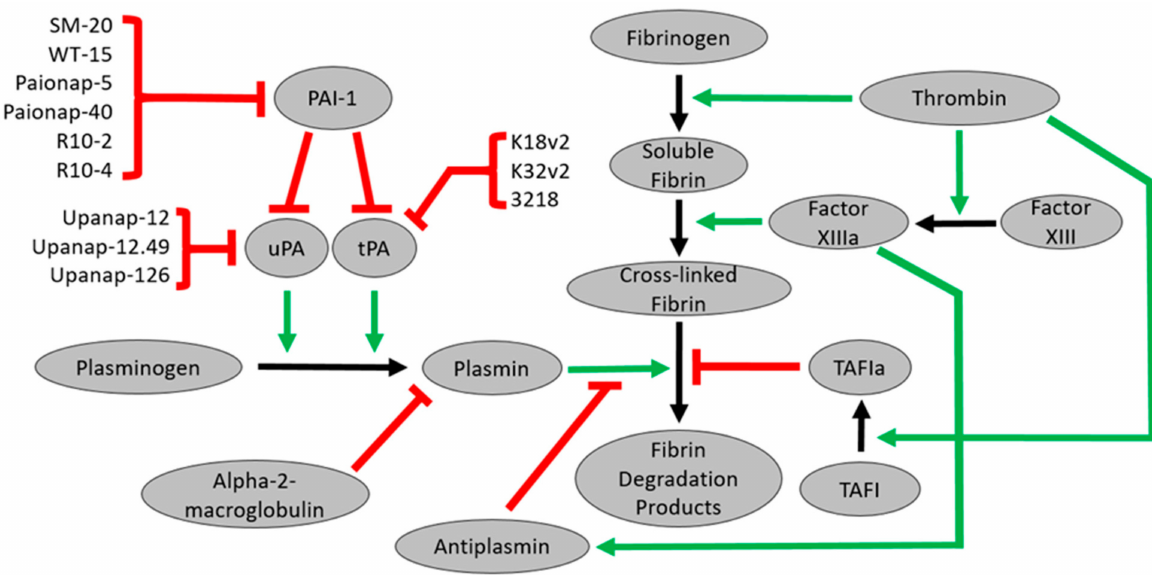
Figure 4. Fibrinolysis pathway aptamers. Paionap-5, paionap-40, SM-20, and WT-15 bind PAI-1, but these aptamers do not alter the PAI-1 antiproteolytic activity. R10-2 and R10-4 inhibit the PAI-1 antiproteolytic against tPA but do not affect PAI-1 interactions with uPA. Upanap-126 inhibits activation of uPA but does not inhibit uPA-mediated plasminogen activation. Upanap-12 and upanap-12.49 inhibit uPA from binding to uPA receptor (uPAR), but neither inhibits uPA catalytic activity. K18v2 and K32v2 are tPA aptamers that inhibited tPA from interacting with LRP-1. The bivalent aptamer 3218 is a potent fibrinolysis inhibitor (Appendix